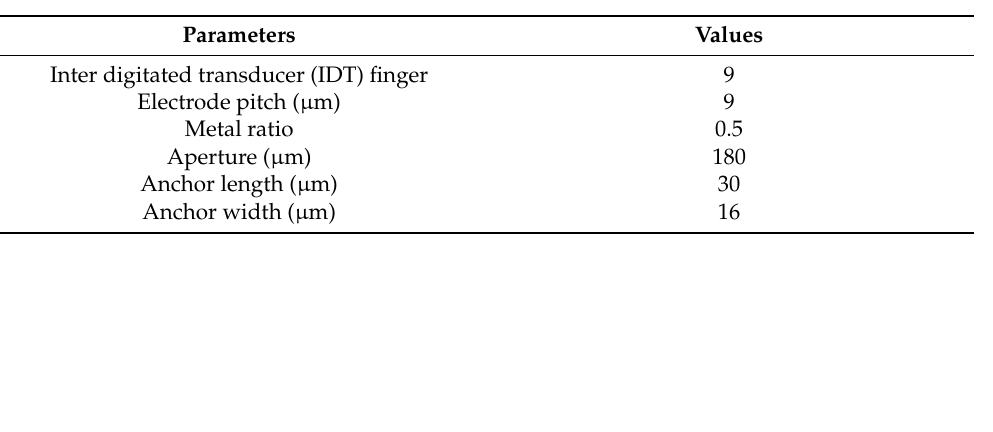
Table 2. Parameters of the lamb wave resonator.